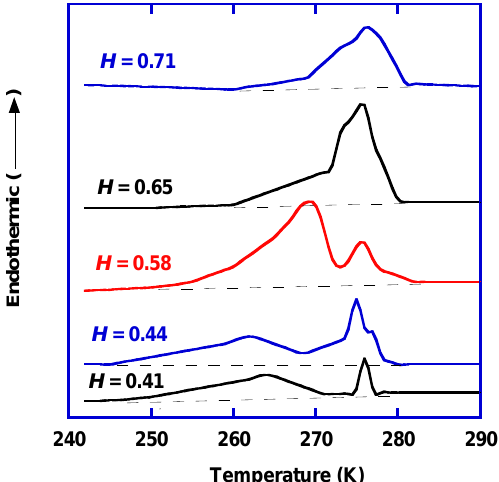
Figure 3. DSC heating curves for the swollen PVA with different degrees of water sorption ( H ). Adapted from [17].